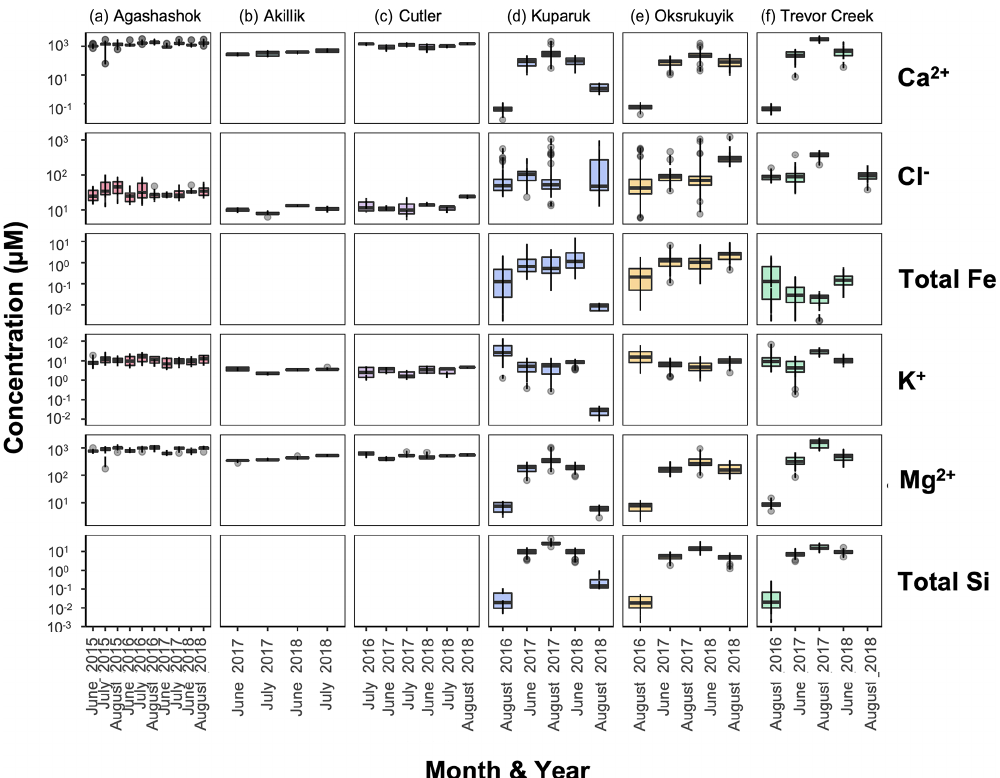
Figure 5. Boxplots of Ca 2 + , Cl − , Fe (total for NPS/USGS; nominally dissolved for TFS), K + , Mg 2 + , and total Si concentration ranges (in µM) in the (a) Agashashok River, (b) Akillik River, (c) Cutler River, (d) Kuparuk River, (e) Oksrukuyik Creek, and (f) Trevor Creek watersheds across all years and seasons sampled. Each box encapsulates values within the lower 25th and upper 75th quartiles respectively, while the whiskers represent the minimum and maximum quartiles. Within each box, the horizontal line represents the median leverage value. Data points outside the whiskers represent values above and below 1 . 5 × the IQR